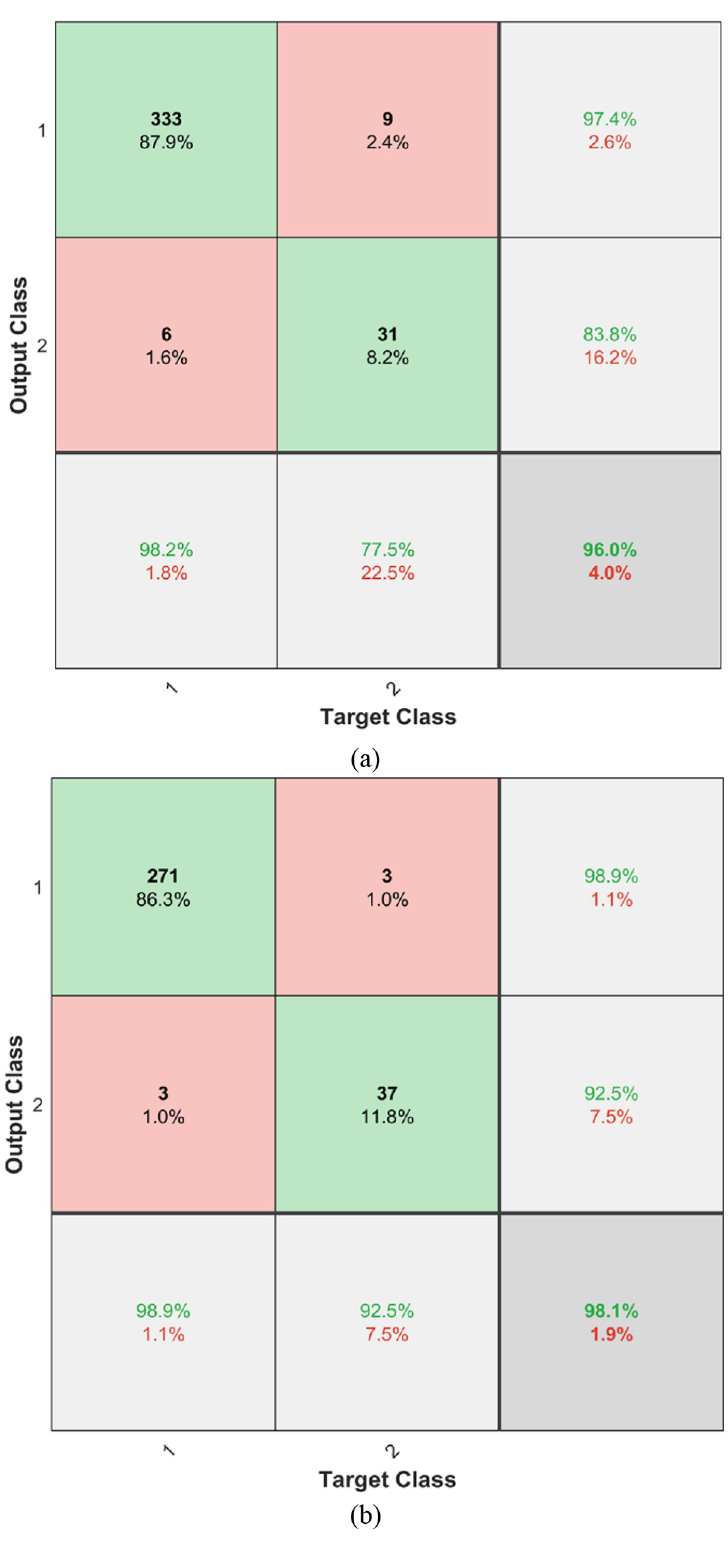
Fig 5. Confusion matrix using MRFODE for (A) dataset-1 and (B) dataset-2.